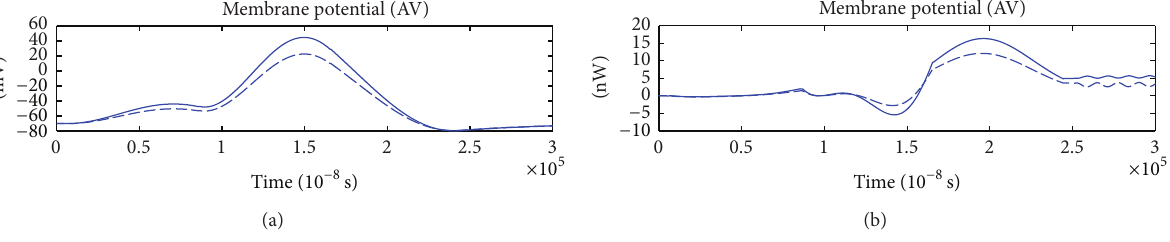
Figure 6: The action potential and its corresponding energy function. 𝑟 0𝑚 = 0.0001 Ω , 𝑟 1𝑚 = 0.1 Ω , 𝑟 2𝑚 = 1000 Ω , 𝑟 3𝑚 = 0.1 Ω , 𝑟 𝑚 = 1000 Ω , = 1 𝜇 F, 𝐿 = 50 𝜇 H, 𝑖 = 70.7 𝜇 A, and 𝑄 = 1 × 10 −5 𝜇 A. 𝐶 𝑚 𝑚 0𝑚